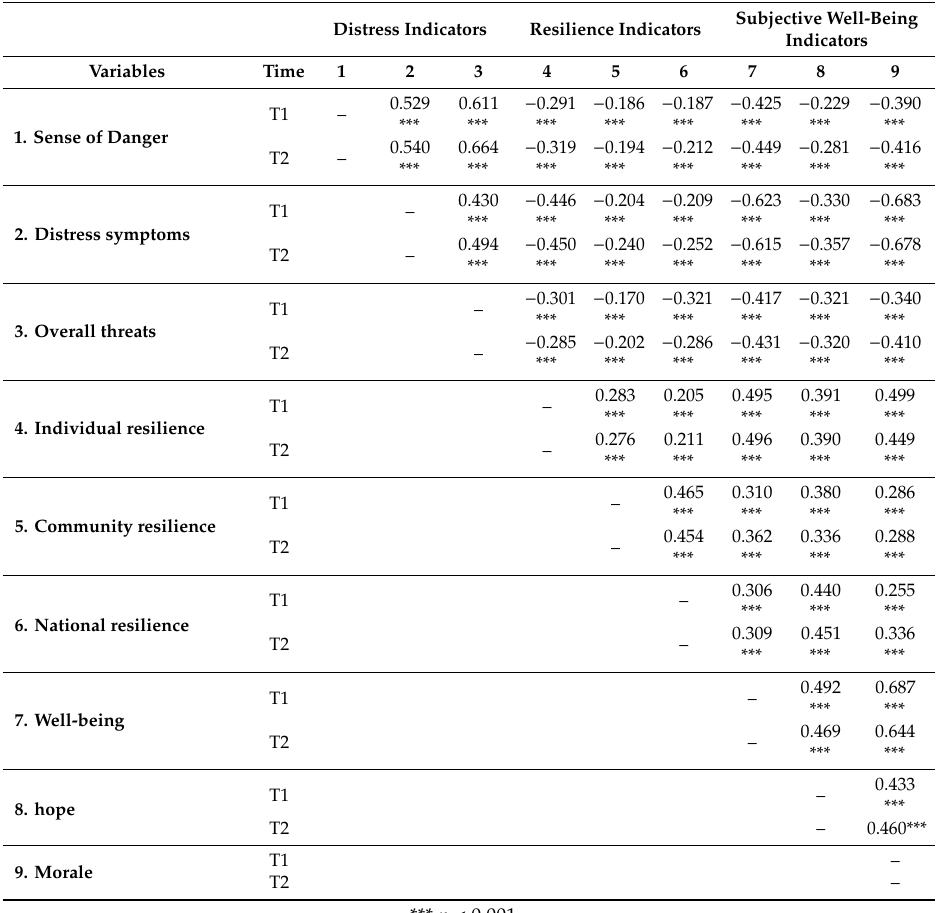
Table 2. Pearson correlations among distress, resilience, and subjective quality of life indicators ( n = 906).